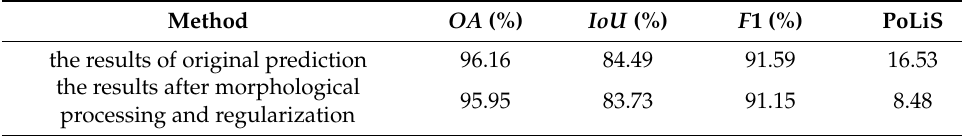
Table 7. Accuracy of building prediction vector